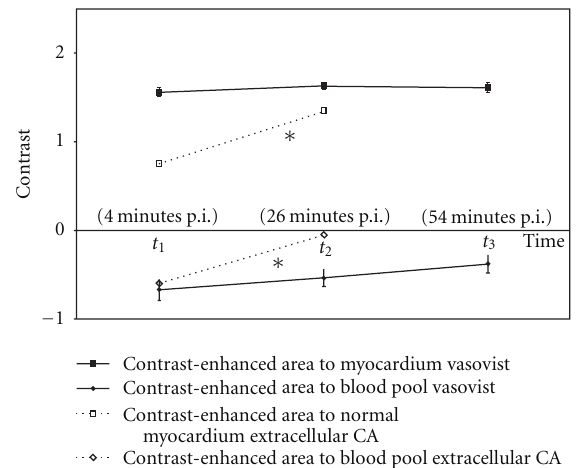
Figure 3: Contrast between enhanced area and normal myocardium increased from t 1 to t 3 as enhanced segments showed increasing signal intensities and normal myocardium is assumed to be e ff ectively nullified using the correct inversion prepulse (look locker approach). As blood pool consistently showed the highest signal intensity over the time, blood pool-enhanced area contrast decreased from t 1 to t 2 and t 3 due to increasing SI in the enhanced area and nearly constant SI of the blood pool. The dotted line ( ∗ ) shows data for the extracellular CA Gd-DTPA extracted from a previous study [22]. Using Gd-DTPA (0.2mmol/kg body weight), the contrast between enhanced area and normal myocardium increased continuously 4 minutes ( t 1 ) and 26 minutes ( t 2 ) after CA administration. Contrast between enhanced area and blood pool decreased from t 1 to t 2 (prepulse delay 275ms, TE 3.6 ms, TR 8ms, flip angle 15 ◦